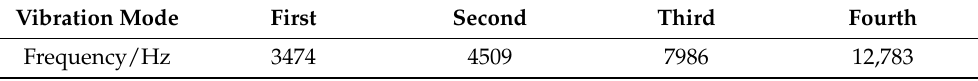
( d ) Figure 13. Vibration mode of bevel driven gear: ( a ) 1st; ( b ) 2nd; ( c ) 3rd; ( d ) 4th.